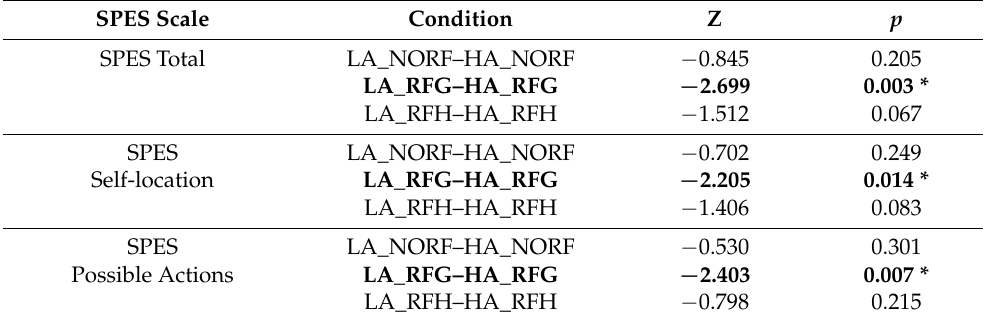
Table 10. Wilcoxon signed-rank test for presence—SPES scores between the modes of the game (LA vs. HA).